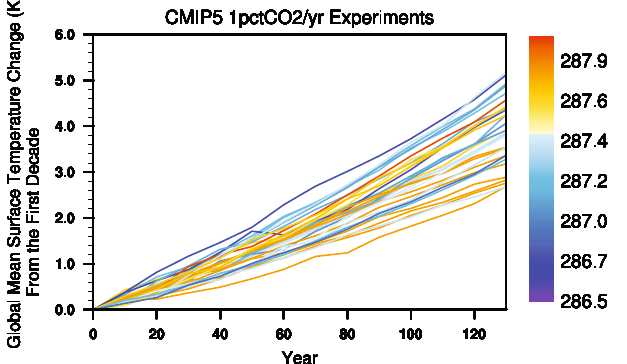
Figure 1. Time series of global mean surface temperature change of the 31 CMIP5 1pctCO2 experiments relative to their corresponding first 10-year averages (labeled as “Year 0” which has been set to zero for each curve). The color scheme for these 31 curves represents the global and time mean surface temperature of the first 10-year simulations of the 31 CMIP5 1pctCO2 experiments. The color scheme is arranged in such a way that the control climate state ranges from the coldest to the warmest as the color changes from blue to